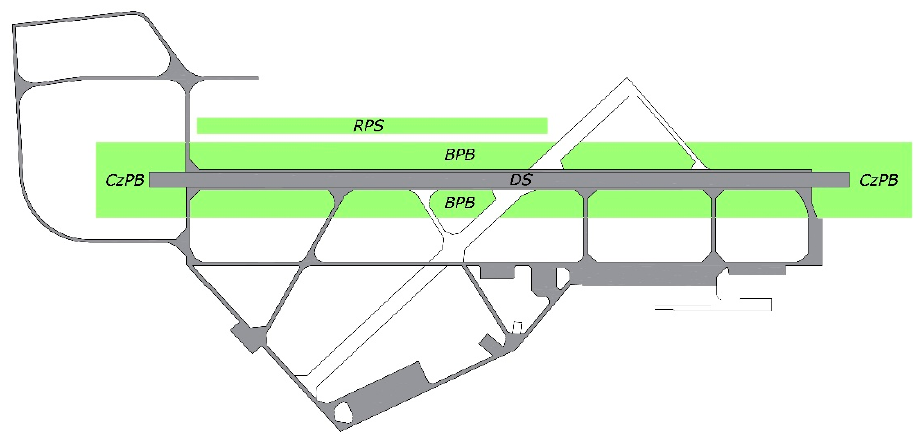
Figure 2. The AFE layout diagram.